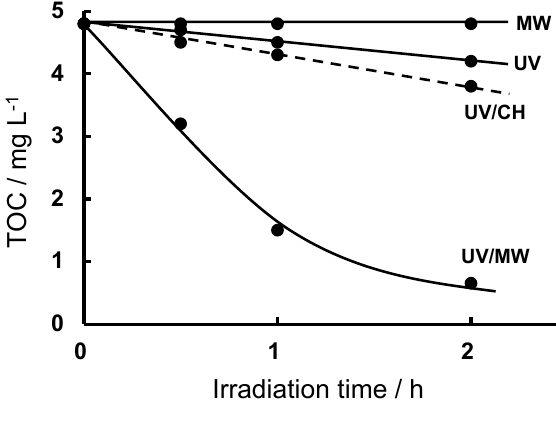
Figure 5. Decrease of TOC for the degradation of 1,4-dioxane. Reproduced from [34]. Copyright 2002 by the Japan Society of Color